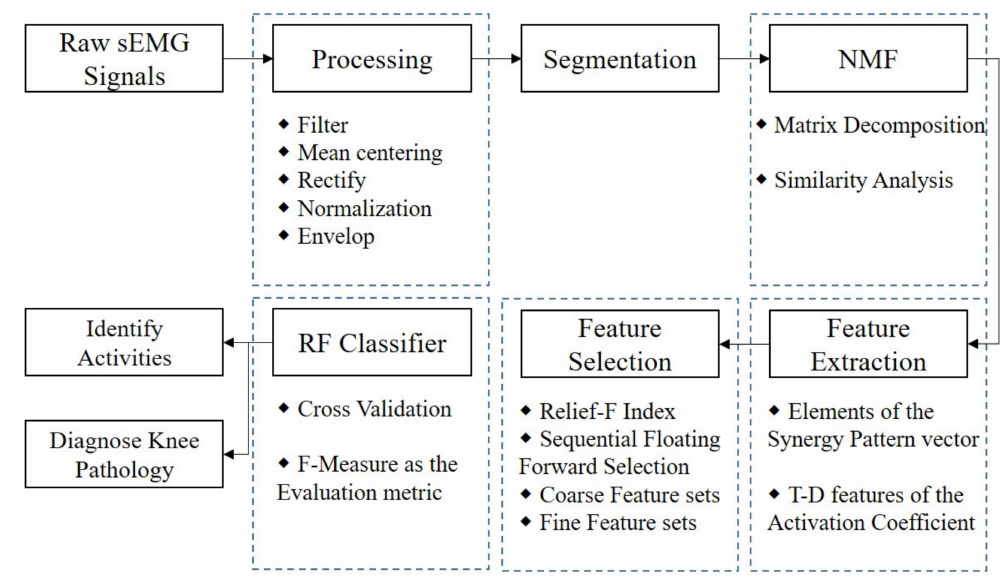
Figure 2. Schematic diagram of the NMF-based sEMG classifier for lower limb motions identification and knee pathology